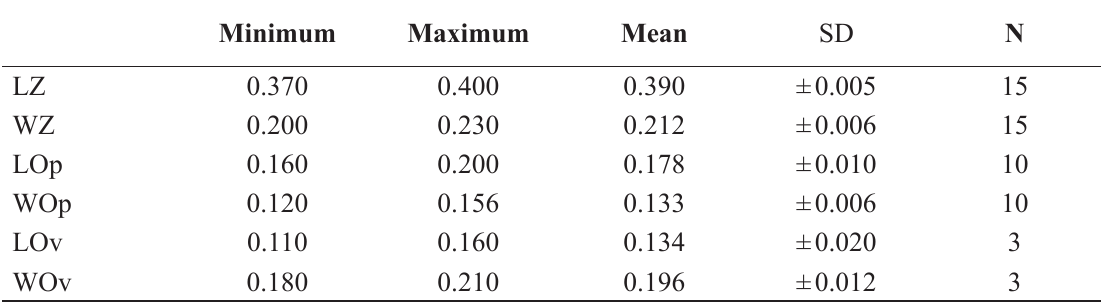
Table 2. Measurements in mm of ? Licornia sp. 1 (GIS/B 0439), Burdigalian, lower Miocene, Chhasra Formation, western Kachchh, Gujarat, India. Abbreviations: see Material and